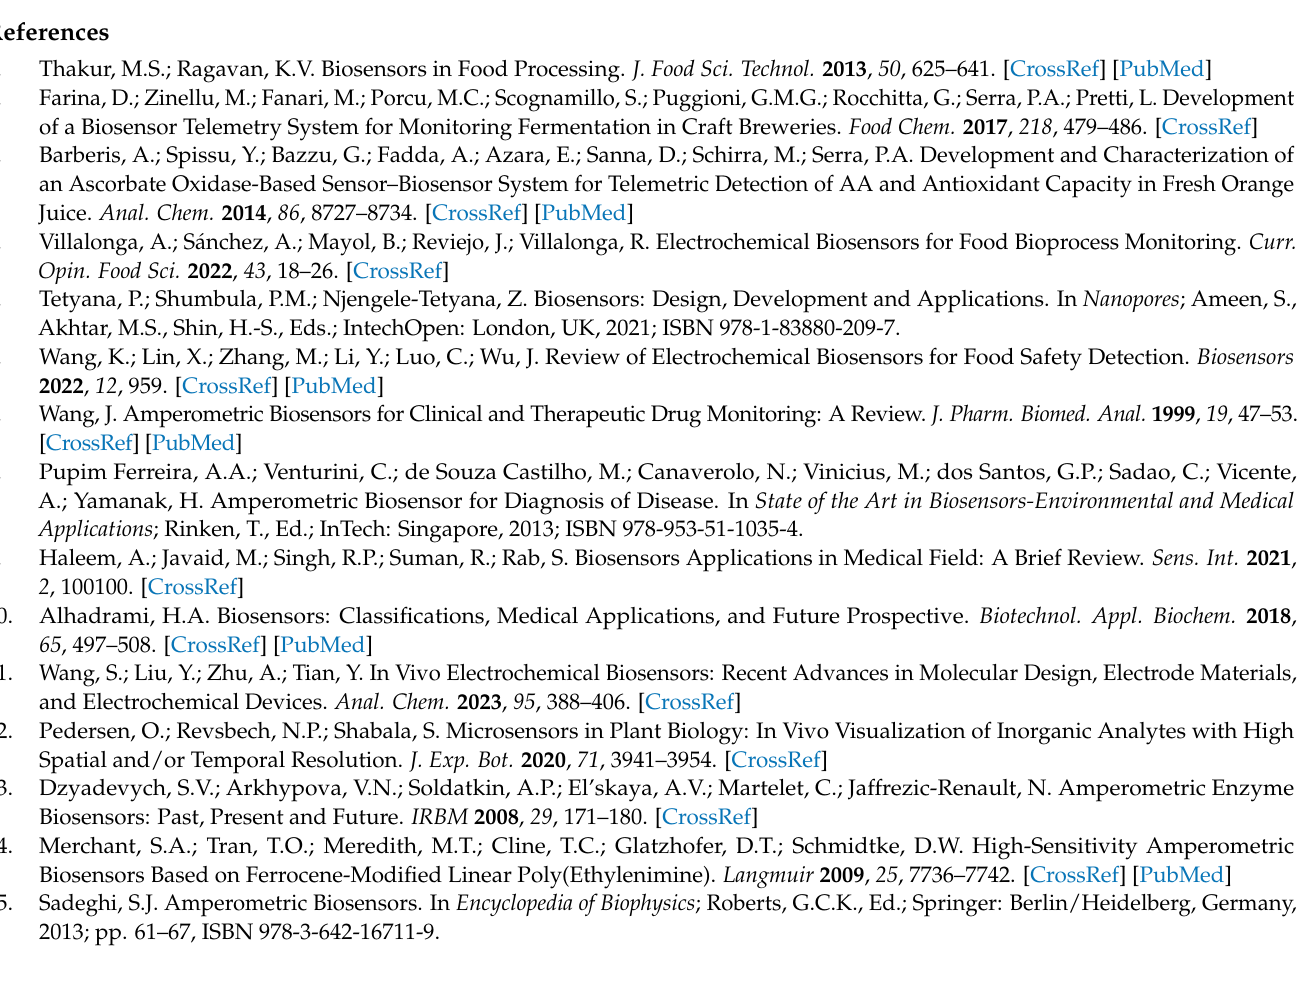
scanning micrograph is shown, while on the right spectra and percentage composition are reported instead. The orange cross indicates the exact area where the the spectrometric analysis was carried out. Figure S11: Scanning electron micrographs of 0.3 mm Ø PL-based sensor at 800 × (Panel A) and 1800 × (Panel B) of magnification. In Panel C the EDX spectrometric analysis of a specific area of the surface is reported. The orange cross indicates the exact area where the spectrometric analysis was carried out. Figure S12: Scanning electron micrographs of PL-based sensor at 800 × (Panel A) and 1800 × (Panel B) magnification. In Panel C the EDX spectrometric analysis of a specific area of the surface is reported. The orange cross indicates the exact area where the spectromet- ric analysis was carried out. Figure S13: AA slopes, expressed as nA/ µ M ± SEM, calculated for PLs 0.3 mm of diameter before and after biosensor (n = 4) construction. Data were obtained on bare C (white column), after platinization (red column) and after PPD deposition (blue column). *: p < 0.001 vs. on bare